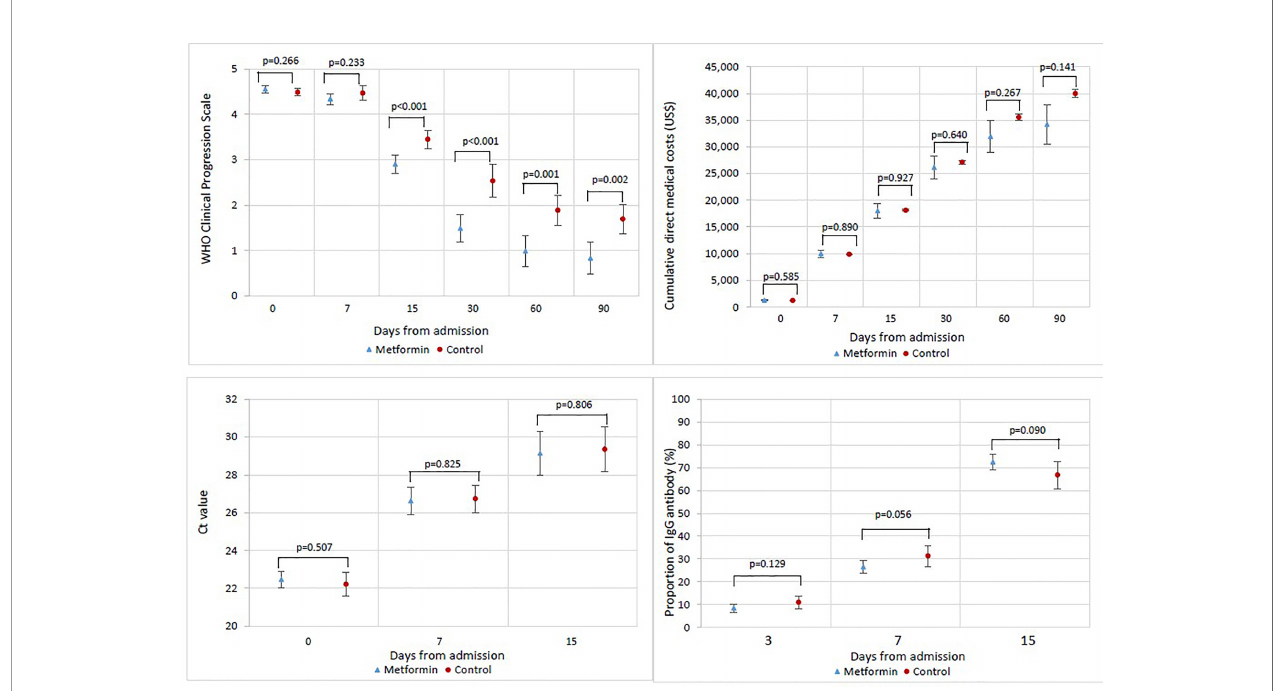
FIGURE 2 | Changes in WHO Clinical Progression Scale score, cumulative direct medical costs, cycle threshold (Ct) value, and proportion of patients with IgG antibody from baseline to day-90 among patients by treatment